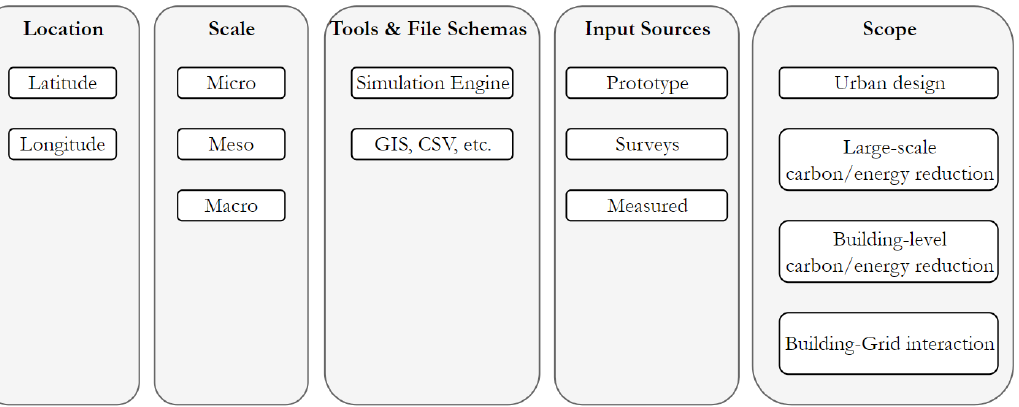
Figure 3. Physics-based urban building energy modeling project definition, data, and metadata ex- traction approach and categories.